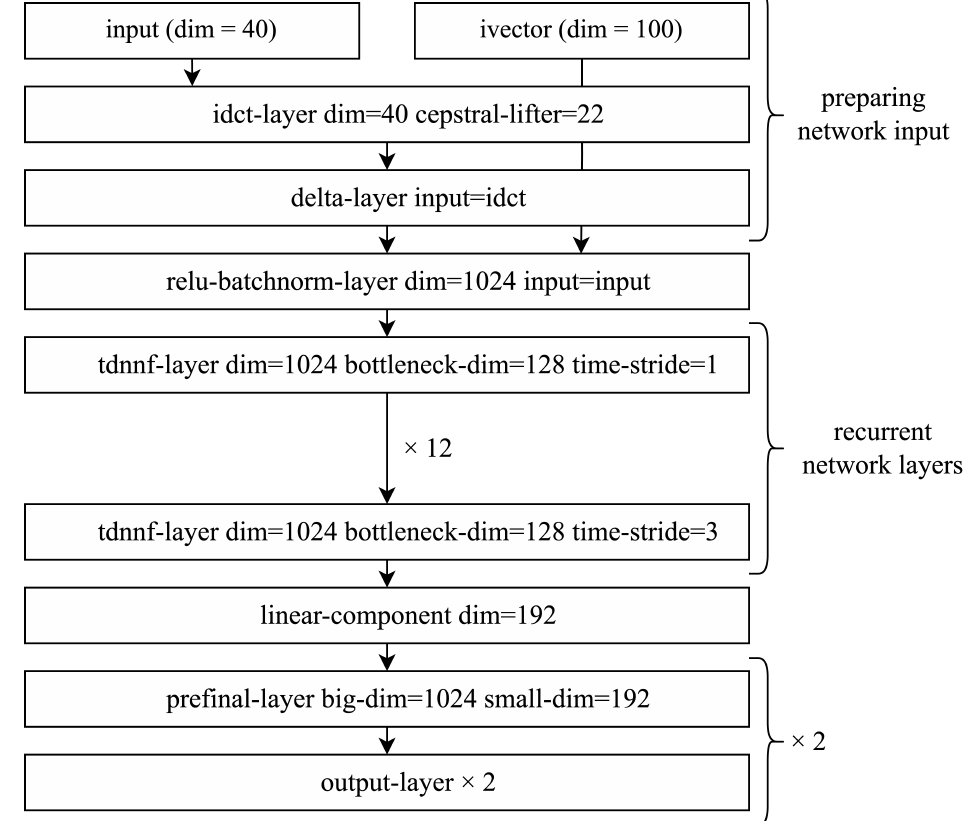
Figure 6. Model architecture for Automatic Speech Recognition